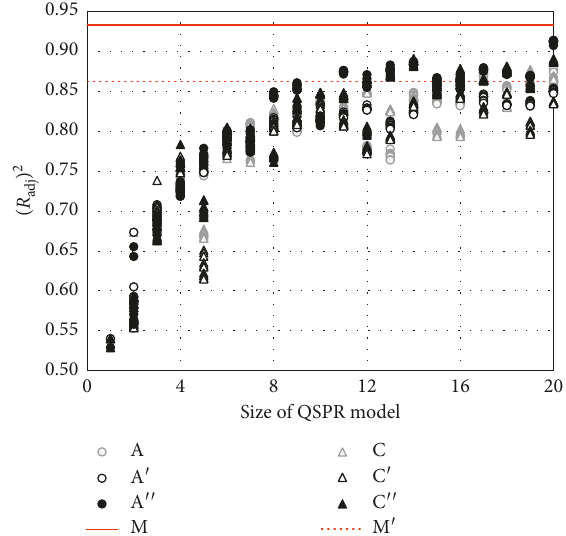
2 values characterizing a variety of Figure 8: Distributions of R adj ) ( QSPR models predicting the p Hansen solubility parameter based on PaDEL descriptors or factors resulting from MARSplines models. Notation is the same as in Figure 7.